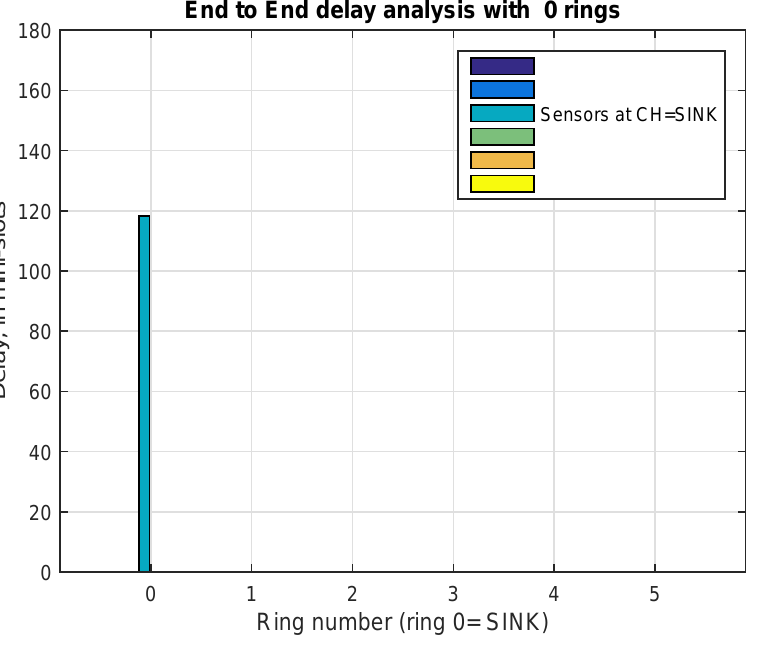
Figure 6. End to end delay (in mini-slots), from sensor to the sink, for r max = 0, p act = 0.001 and ( N ) = ( 63,1;0,0 ) msC , N intra ; N msT , N inter